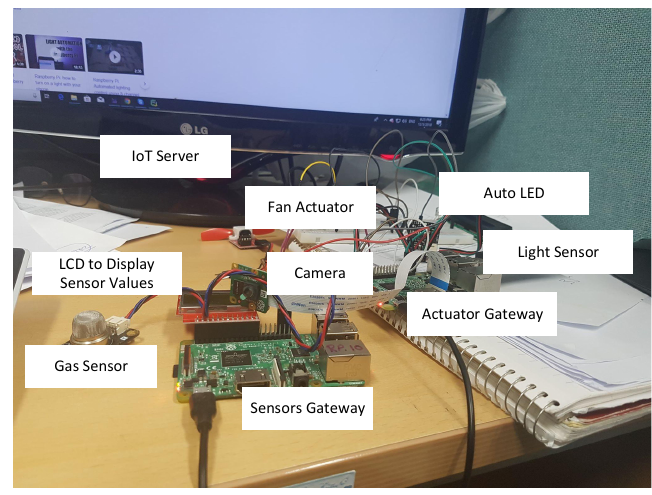
Figure 8. Embedded system for driver-assistance system